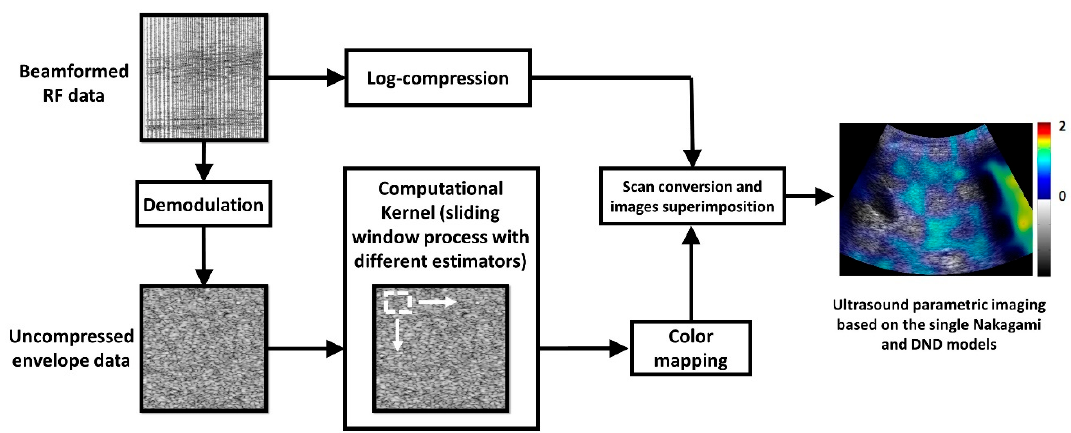
Figure 1. Illustration of the algorithm for ultrasound parametric imaging based on the single Nakagami and the double Nakagami distribution (DND) models. The sliding window was used to process the uncompressed envelope image, generating a parametric map to be superimposed on the B-mode image for the final display of the parametric